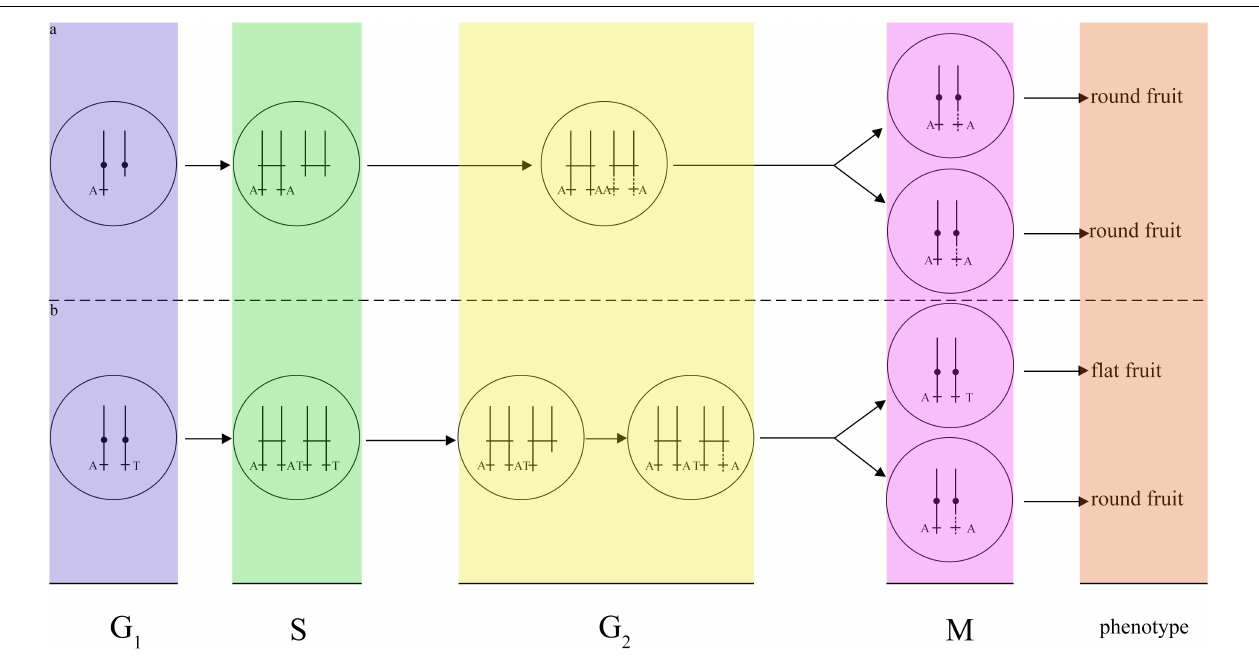
FIGURE 5 | Models of two possible mechanisms for the fruit shape LOH event. (a) Break-induced replication in G1. If DNA damage occurs in G1, the cell will repair the DNA using a homologous chromosome in G2, resulting in only one type of daughter cell with the same round-type fruit phenotype. (b) Break-induced replication in G2. If DNA lesions occurred in G2, the cell will repair the DNA using a homologous chromosome in G2, and resulting in two types of daughter cells, one of which will have a round-type fruit phenotype and the other of which will have a flat-type fruit phenotype.